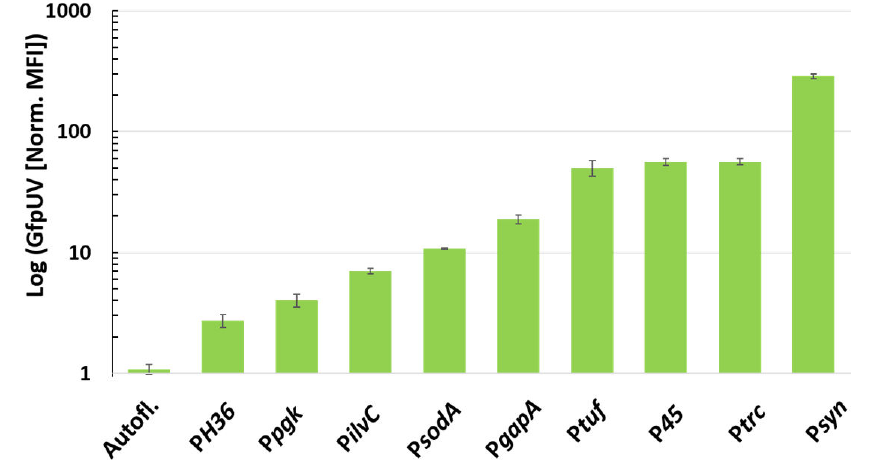
Figure 1. Fluorescence reporter assay of a promoter library in the pECXT99A plasmid background in C. glutamicum WT. Median GfpUV fluorescence intensities were normalized to an autofluorescent control. Mean values and standard deviations of biological triplicates are shown. Measurements were performed 18 h after inoculation in CGXII medium with 4% glucose. Endogenous promoters: P pgk , P ilvC , P sodA , P gapA , and P tuf . Synthetic promoters: P H36 , P 45 , and P syn . Reference: the IPTG-inducible promoter P trc induced with 1 mM